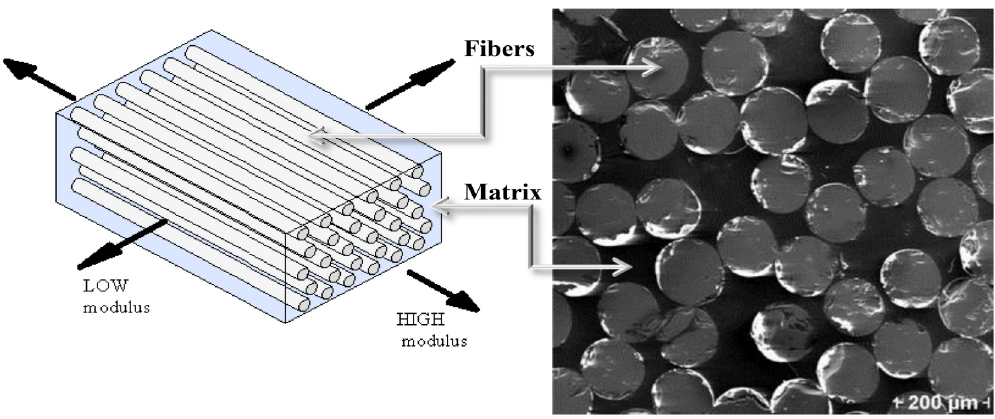
Figure 1. Schematic of fiber-reinforced composites [1].